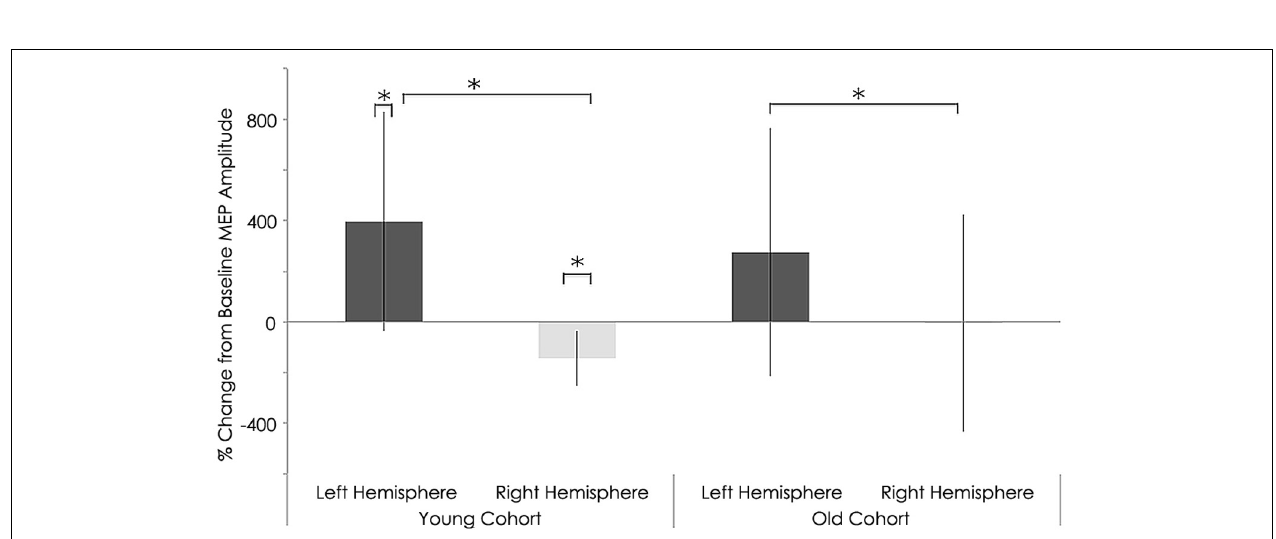
FIGURE 6 | Interhemispheric characteristics for short intracortical inhibition (SICI) and intracortical facilitation (ICF). (SICI) at interstimulus intervals of 3ms and ICF at 12ms (normalized and express as 100% level) of